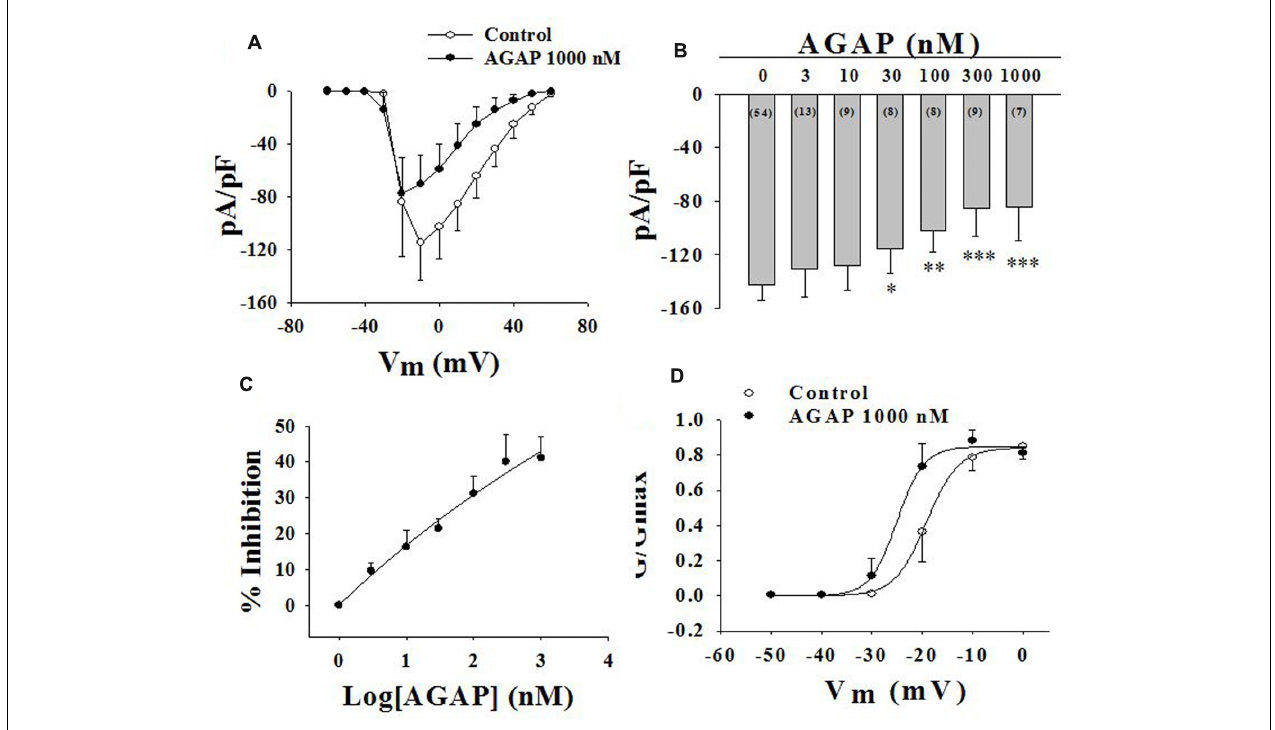
FIGURE 6 | Effect of AGAP on Na V channel currents in small-diameter DRG neurons. (A) Current density-voltage relationship obtained by plotting current density as a function of test potential under control conditions and after application of 1000 nM AGAP. ( n = 7). (B,C) The graph shows the dose–response relationship of the effect of AGAP in acutely isolated small-diameter DRG neurons ( ∗ P < 0.05, ∗∗ P < 0.01, ∗∗∗ P < 0.001, P values are from unpaired t -test. n = 8–13). (D) Effect of AGAP on steady-state activation kinetics of Na V channels. Data points were fitted with the Boltzmann equation. V 1 / 2 was − 19.1 ± 0.3 mV under control conditions and − 25.0 ± 0.7 mV in the presence 1000 nM of AGAP ( P < 0.05, P values are from unpaired t -test. n = 7); slope factors were 3.2 ± 0.3 and 2.7 ± 0.3 mV,